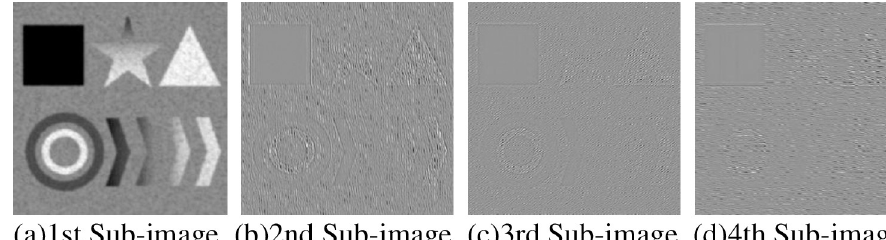
Fig 4. Decomposition effect diagram of composite.